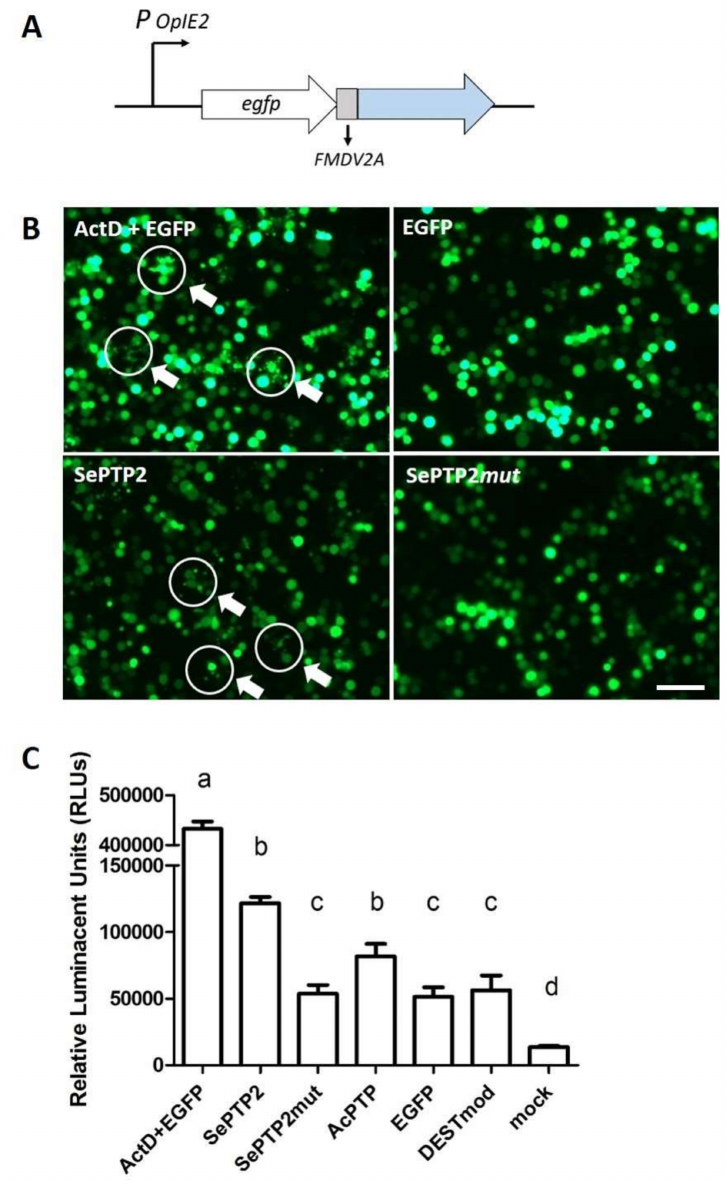
Figure 1. Transient expression of the Spodoptera exigua protein tyrosine phosphatase 2 (SePTP2) induced mild apoptosis in Sf21 cells. ( A ) Overview of the expression cassette in the pIB-DEST vector: egfp and the gene of interest were separated by the foot and mouth disease virus (FMDV) 2A region and expression of the cassette was driven by the OpIE2 promoter; ( B ) EGFP expression in Sf21 cells at 48 h post-transfection (hpt) with pIB-EGFP + ActD (ActD + EGFP), pIB-EGFP (EGFP), pIB-SePTP2 (SePTP2), or pIB-SePTP2mut (SePTP2mut), respectively. Apoptotic bodies are indicated by white circles and arrows, scale bar = 200 µ m; ( C ) caspase activity levels in Sf21 cells transfected with pIB-EGFP + ActD (ActD + EGFP), pIB-SePTP2 (SePTP2), pIB-SePTP2mut (SePTP2mut), pIB-AcPTP (AcPTP), pIB-EGFP (EGFP), pIB-DESTmod (DESTmod) and mock. Caspase 3/7 activity in transfected Sf21 cells was measured as relative luminescent units (RLUs) at 48 hpt, relative to a blank containing cell medium. Error bars represent the standard error of the mean. Treatment groups marked with a different letter (a, b, c or d) are significantly different (Table